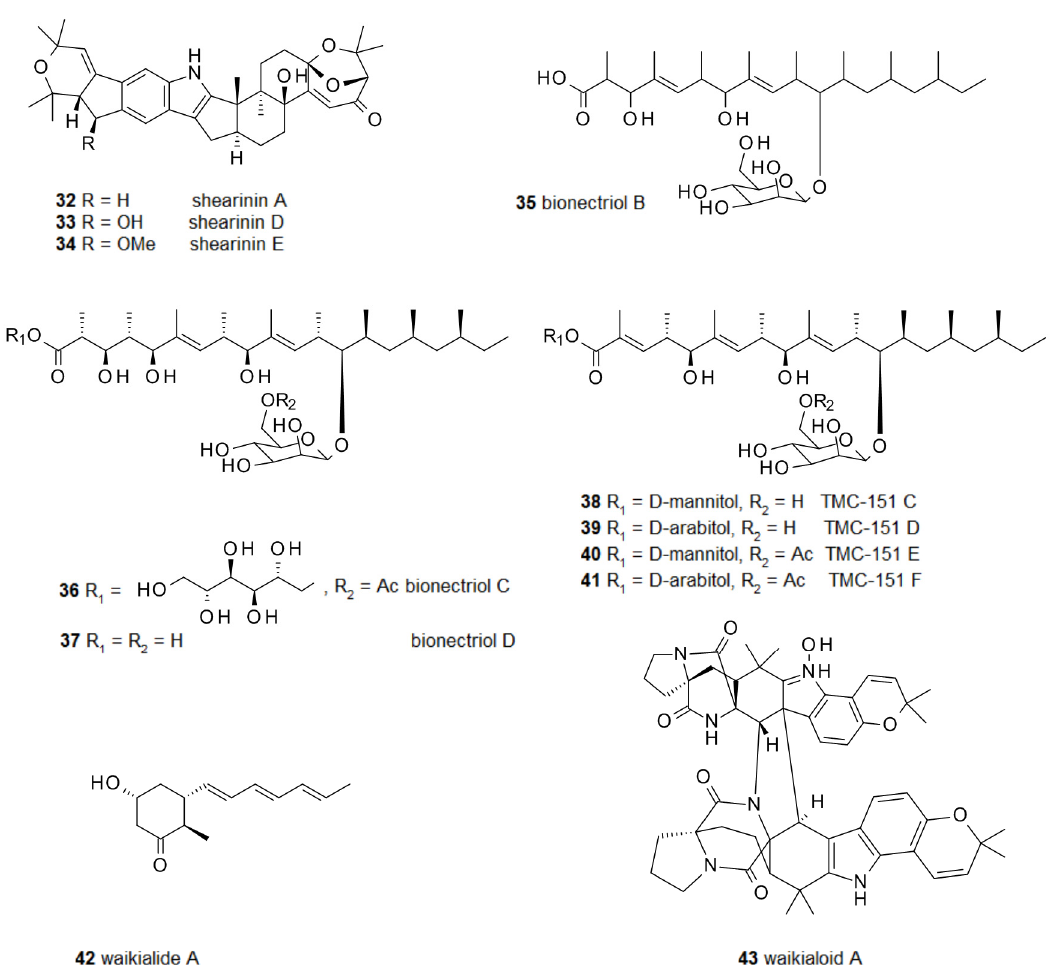
Figure 4. Relatively complex secondary metabolites from fungi directed against biofilms of C. albicans .